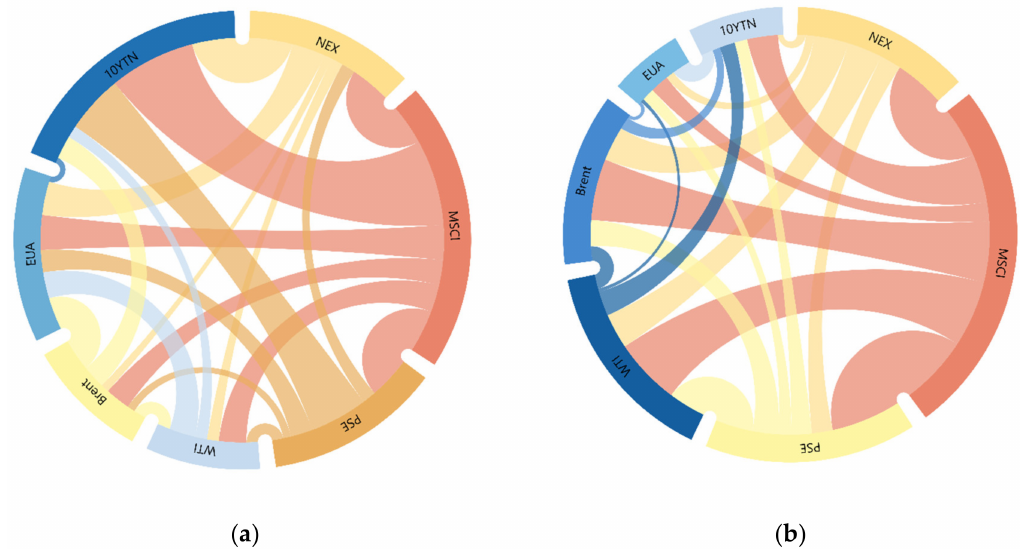
Figure 1. The net pairwise connectedness over the full sample. ( a ) Price Return System. ( b ) Price Volatility System. (Note: In the figure, blue nodes represent net information receivers, and orange nodes represent net information transmitters. The heavier the color is, the stronger the overflow is. The bands between the nodes represent the direction of pairwise connectedness, with orange representing the outflow of spillovers and blue representing the inflow of spillovers. If the width of the band is larger, the connectedness is